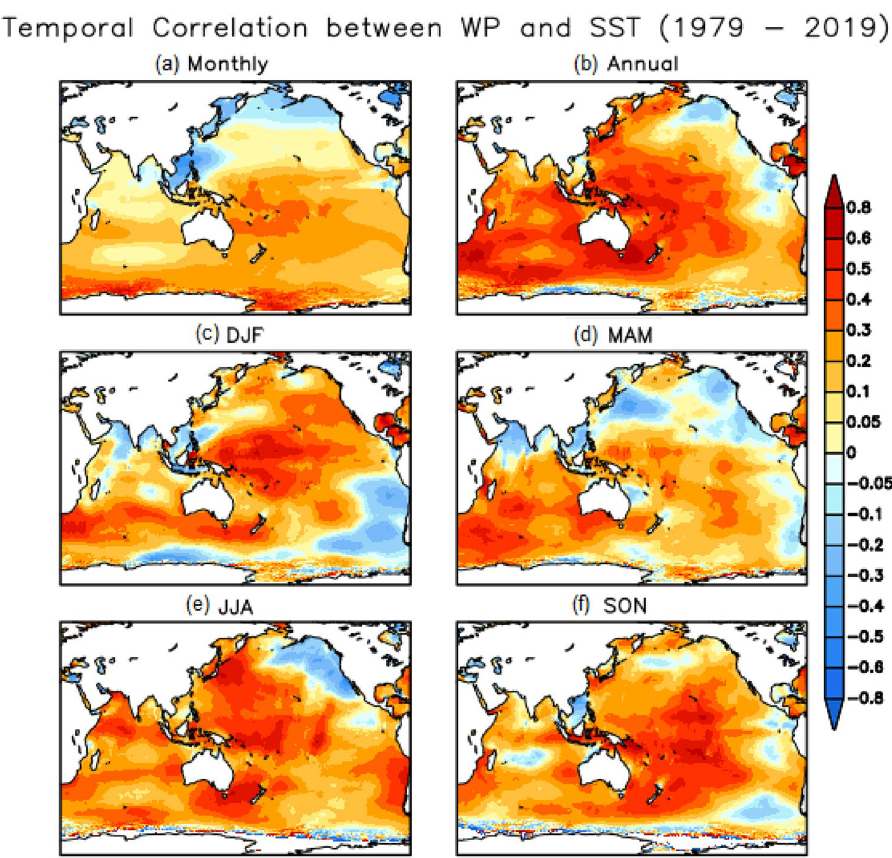
Figure 4. Temporal correlation patternsbetween the mean WP and SST for ( a ) monthly, ( b ) annual, and seasonal ( c ) DJF, ( d ) MAM, ( e ) JJA, and (f) SON time scales in the Indo–Pacific Oceanover the period 1979–